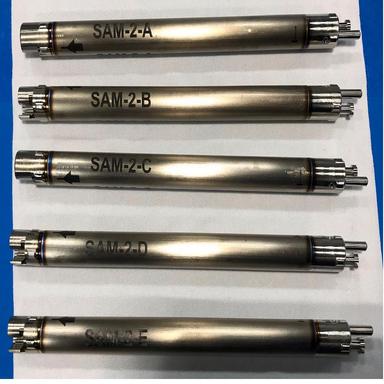
Photograph of the SAM-2 experiment capsule assemblies.